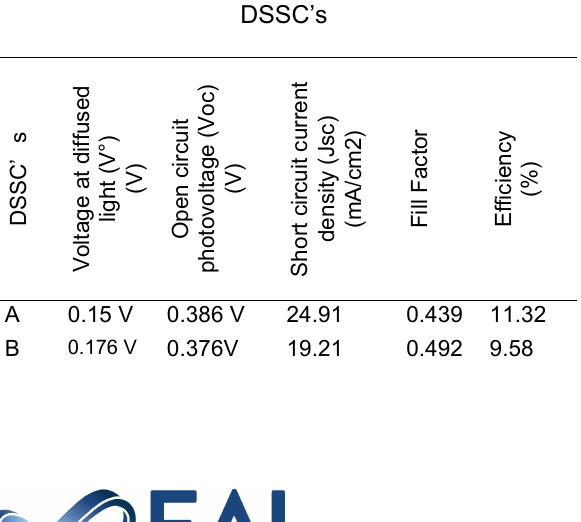
Table 10. Performance comparison of various